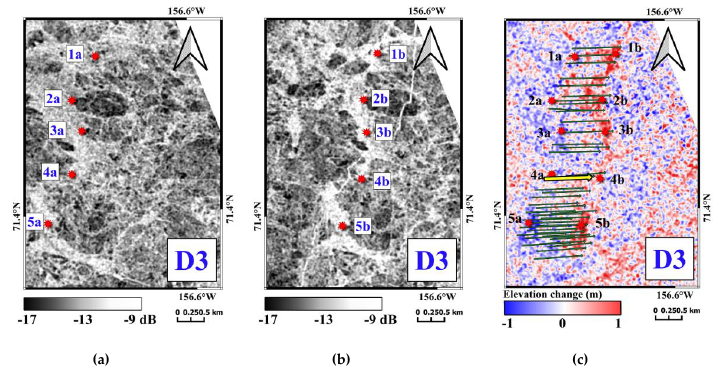
Figure 9. Displacement D3: SAR backscatter intensity on 13 Jan ( a ) and 24 Jan 2012 ( b ). The HDM is displayed in ( c ) with individual displacement vectors in green and average displacement vector in yellow. Control points 1a–5a and 1b–5b represent ridge features that can be recognized before and after the displacement. For D4, as for D3, five control points were identified on the backscatter imagery (Figure 10a,b). The HDM clearly indicates a shift corresponding to the shift indicated by the control points at 0.7 km. The drift algorithm identified a total of 46 vectors along the ridge with a resulting mean displacement of 0.6 km, similar to that indicated in the control points and the HDM (Figure 10c). We were not able to detect the ridge in D3 and D4 in the coastal radar imagery likely due to radar signal disturbance from surrounding rough ice in the near range and a low signal in the far range (not shown).